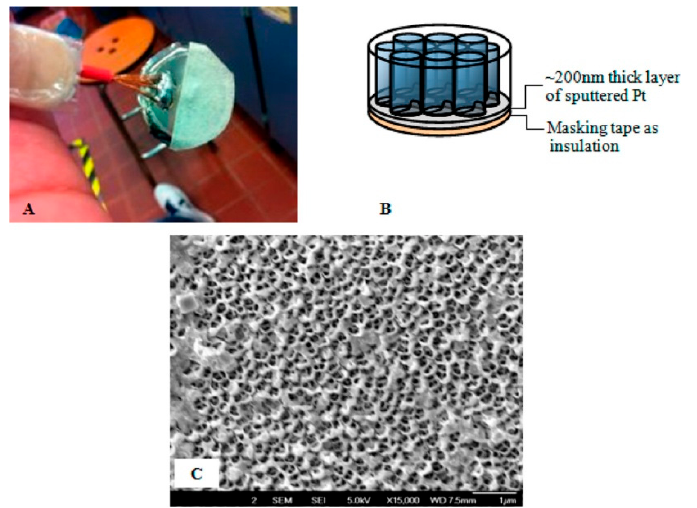
Figure 7. Photograph of the AAO/Pt electrode ( A ) with the general schematic shown in ( B ).